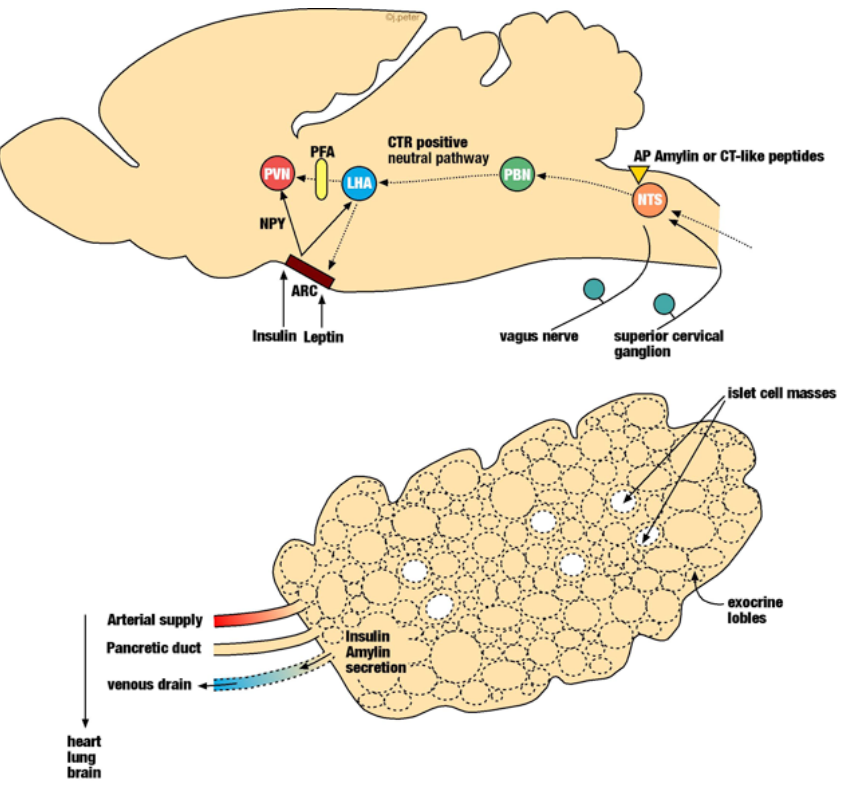
FIGURE 2. Cartoon of the neural and humoral relationship between the CNS and the endocrine pancreas. Abbreviations are area postrema (AP), nucleus of the solitary tract (NTS), parabrachial nucleus (PBN), lateral hypothalamic area (LHA), perifornical area (PFA), paraventricular nucleus (PVN), arcuate nucleus (ARC), neuropeptide Y